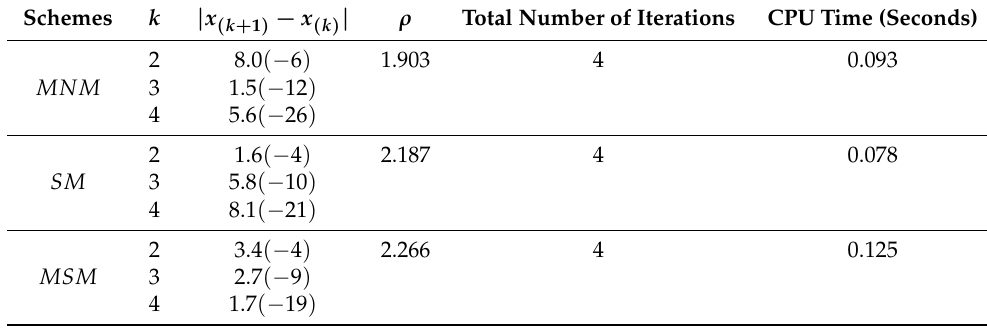
Table 3. Convergence behavior of the methods MNM , SM , and MSM at approximation x 0 = − 2.5. Schemes